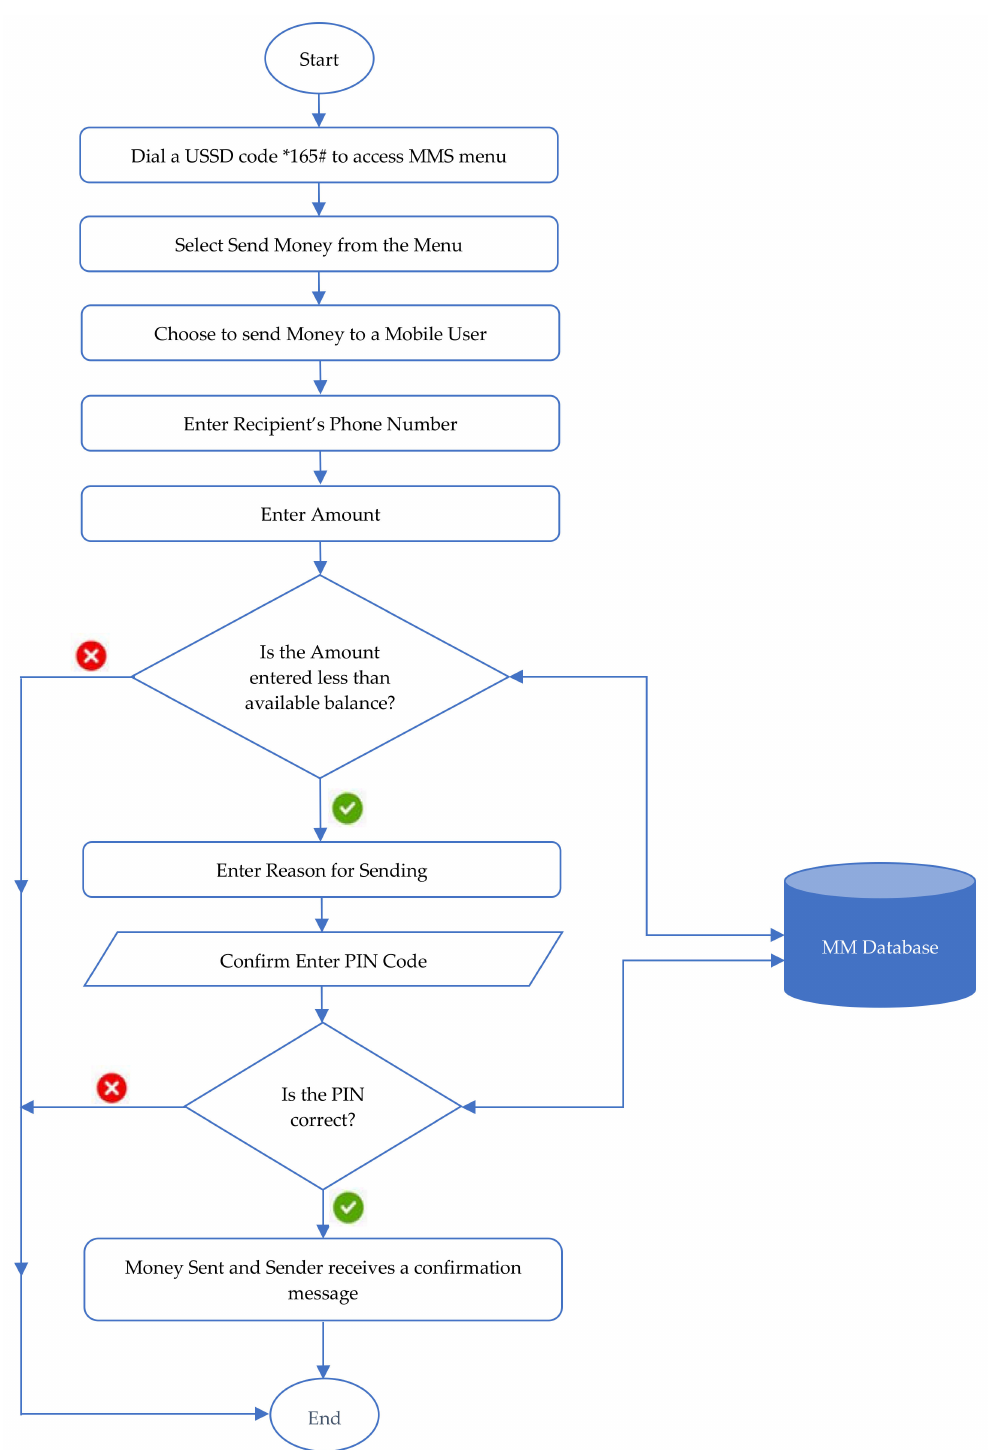
Figure 3. Mobile money authentication